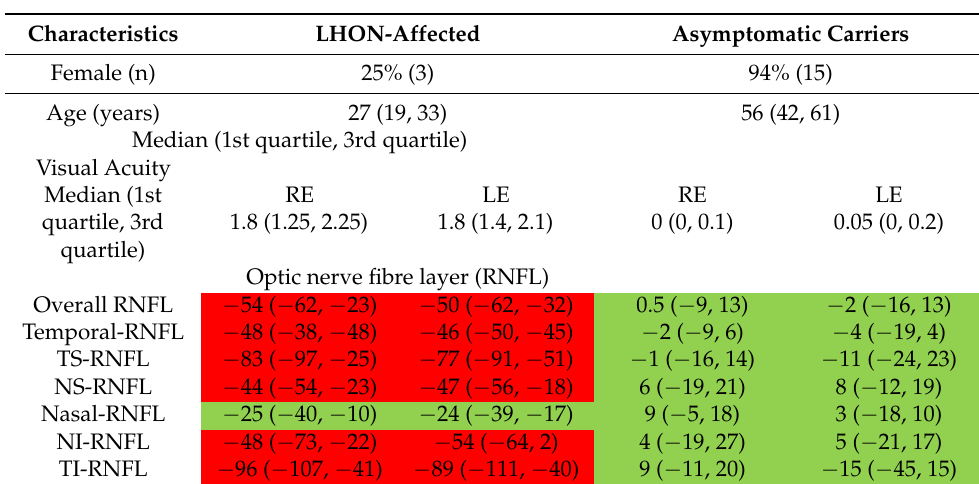
Table 2. Demographic data and optic nerve head thickness: median deviation of retinal nerve fibre layer (RNFL) thickness, visual acuity, sex and age of the LHON-affected and asymptomatic maternal carrier relatives. Visual acuity is displayed in logMAR. The RNFL values are displayed in microns, and highlighted in green where normal and red where thinning is present.